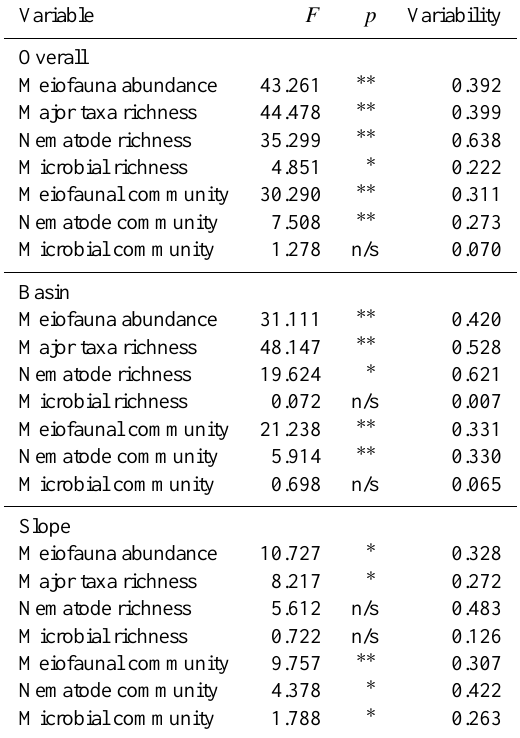
Table 5. Results of DISTLM analysis, a permutational regression routine, for exploring relationships of meiofauna and microbes with depth. p values were obtained using 9999 permutations of